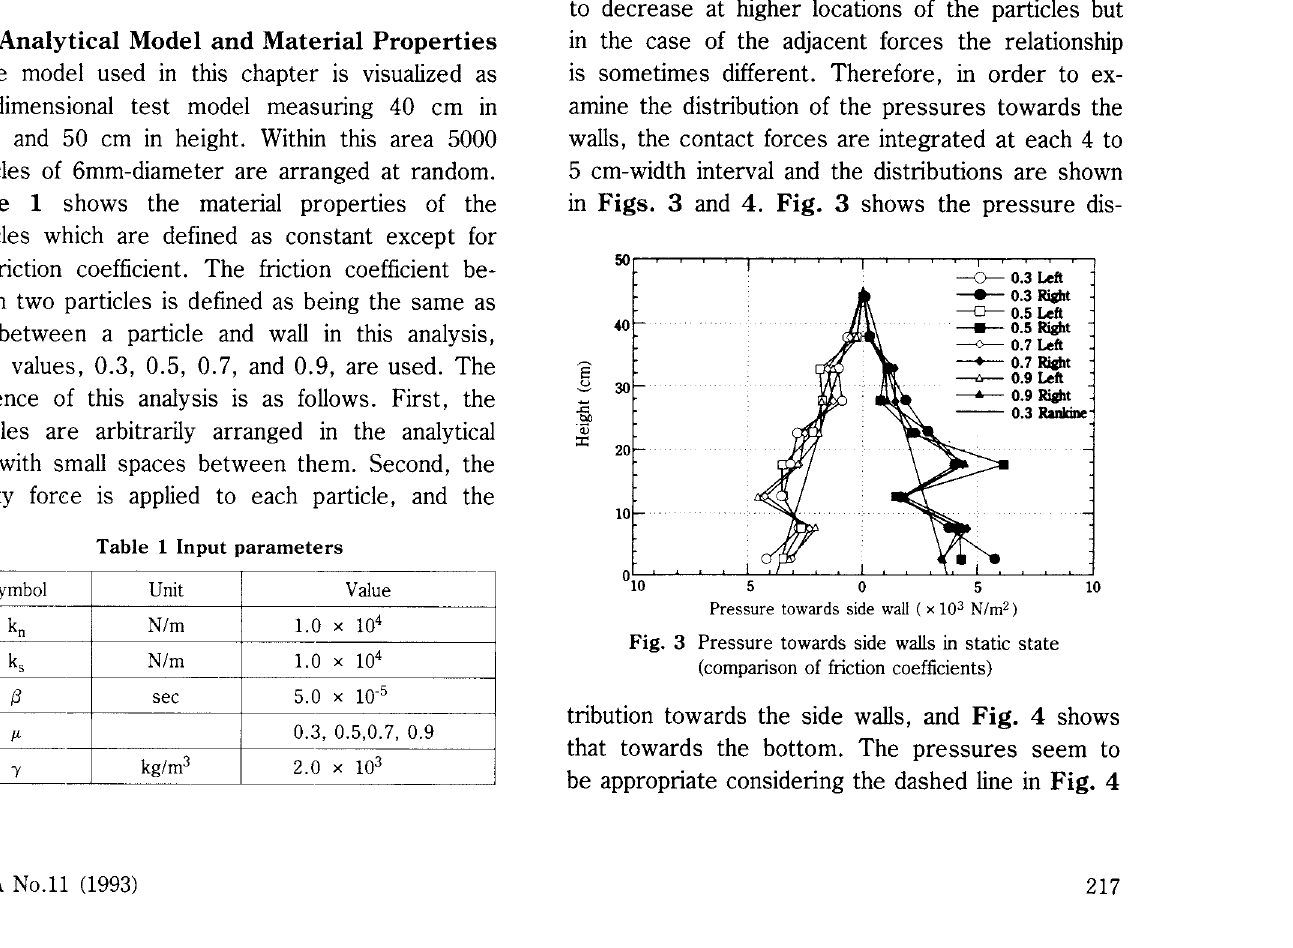
Fig. 3 Pressure towards side walls in static state (comparison of friction coefficients) tribution towards the side walls, and Fig. 4 shows that towards the bottom. The pressures seem to be appropriate considering the dashed line in Fig.